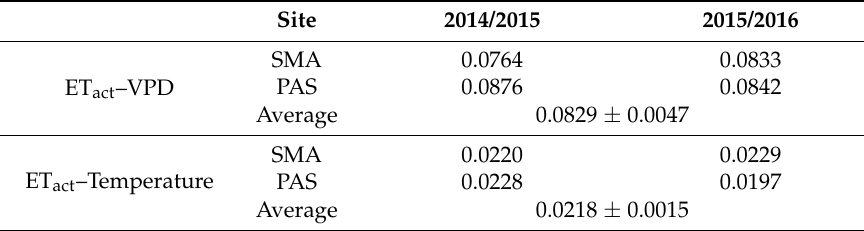
Table 4. Normalized area of hysteresis between ET act and VPD and air temperature for SMA and PAS for different years. The average is represented by mean ± standard